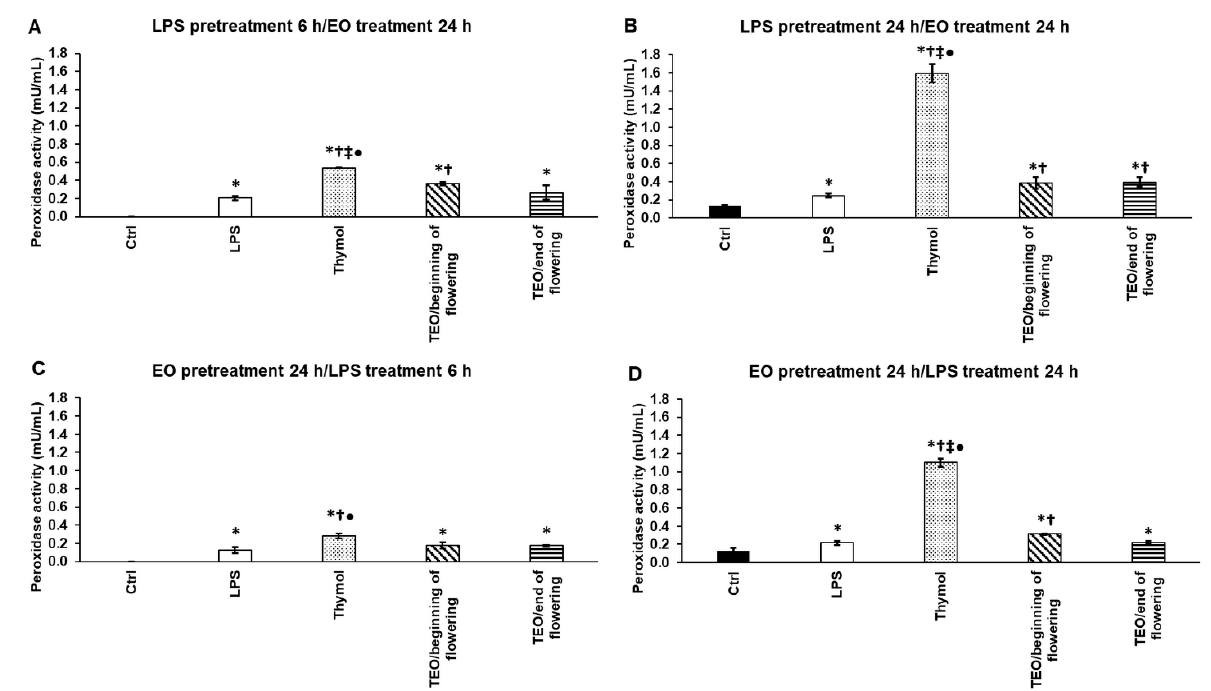
Figure 3. Determination of the effects of thymol and TEOs on peroxidase activity (PX) of the THP-1 cells. As a control, the THP-1 cells were treated with DMSO, the carrier of EOs or distilled water, and the solvent of LPS in the same order and for the same time as in the case of the EO and LPS pretreatments. For LPS treatment, the cells were treated with LPS for 6 h or 24 h, and then 500-fold diluted DMSO was added for 24 h, or the cells were treated with DMSO for 24 h, and then LPS was administered for 6 h and 24 h. For LPS pretreatment, the cells were incubated with LPS for 6 h and 24 h, and then 500-fold diluted thymol or TEOs were added for 24 h. For EO pretreatment, the cells were treated with 500-fold diluted thymol or TEOs for 24 h followed by LPS addition for 6 h and 24 h. Peroxidase activity was determined by Peroxidase Activity Assay Kit according to the protocol of the manufacturer and was expressed as mU/mL. The bars represent mean values, and error bars represent standard deviation (SD) for three independent experiments (n = 3). The assays were carried out in triplicate in each experiment. Asterisk indicates p < 0.05 compared to control. Cross marks p < 0.05 compared to LPS treatment. Double cross shows p < 0.05 compared to TEO/beginning of flowering. Bullet marks p < 0.05 compared to TEO/end of flowering. Statistical analysis was carried out by two-way ANOVA followed by Scheffe’s post hoc test.